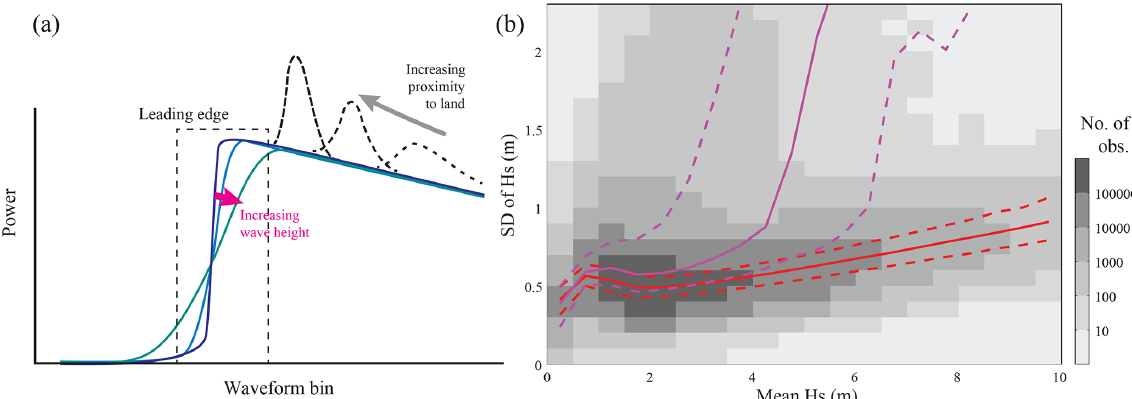
Figure 16. (a) Schematic of how conventional waveforms are affected by varying wave height and proximity to land. (b) Variability within a 1s ensemble as a function of mean conditions. Illustration is from the default retracker for JASON-3, with grey shading indicating the population density for open-ocean conditions and the red lines indicating the 25th, 50th, and 75th percentiles for 0.5m wide bins. Pink lines show the same analysis for points within 15km of the